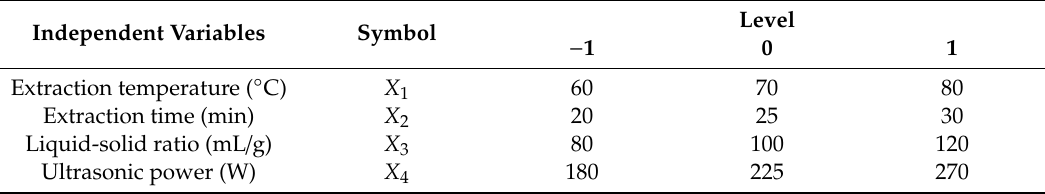
Table 4. Independent variables and levels in